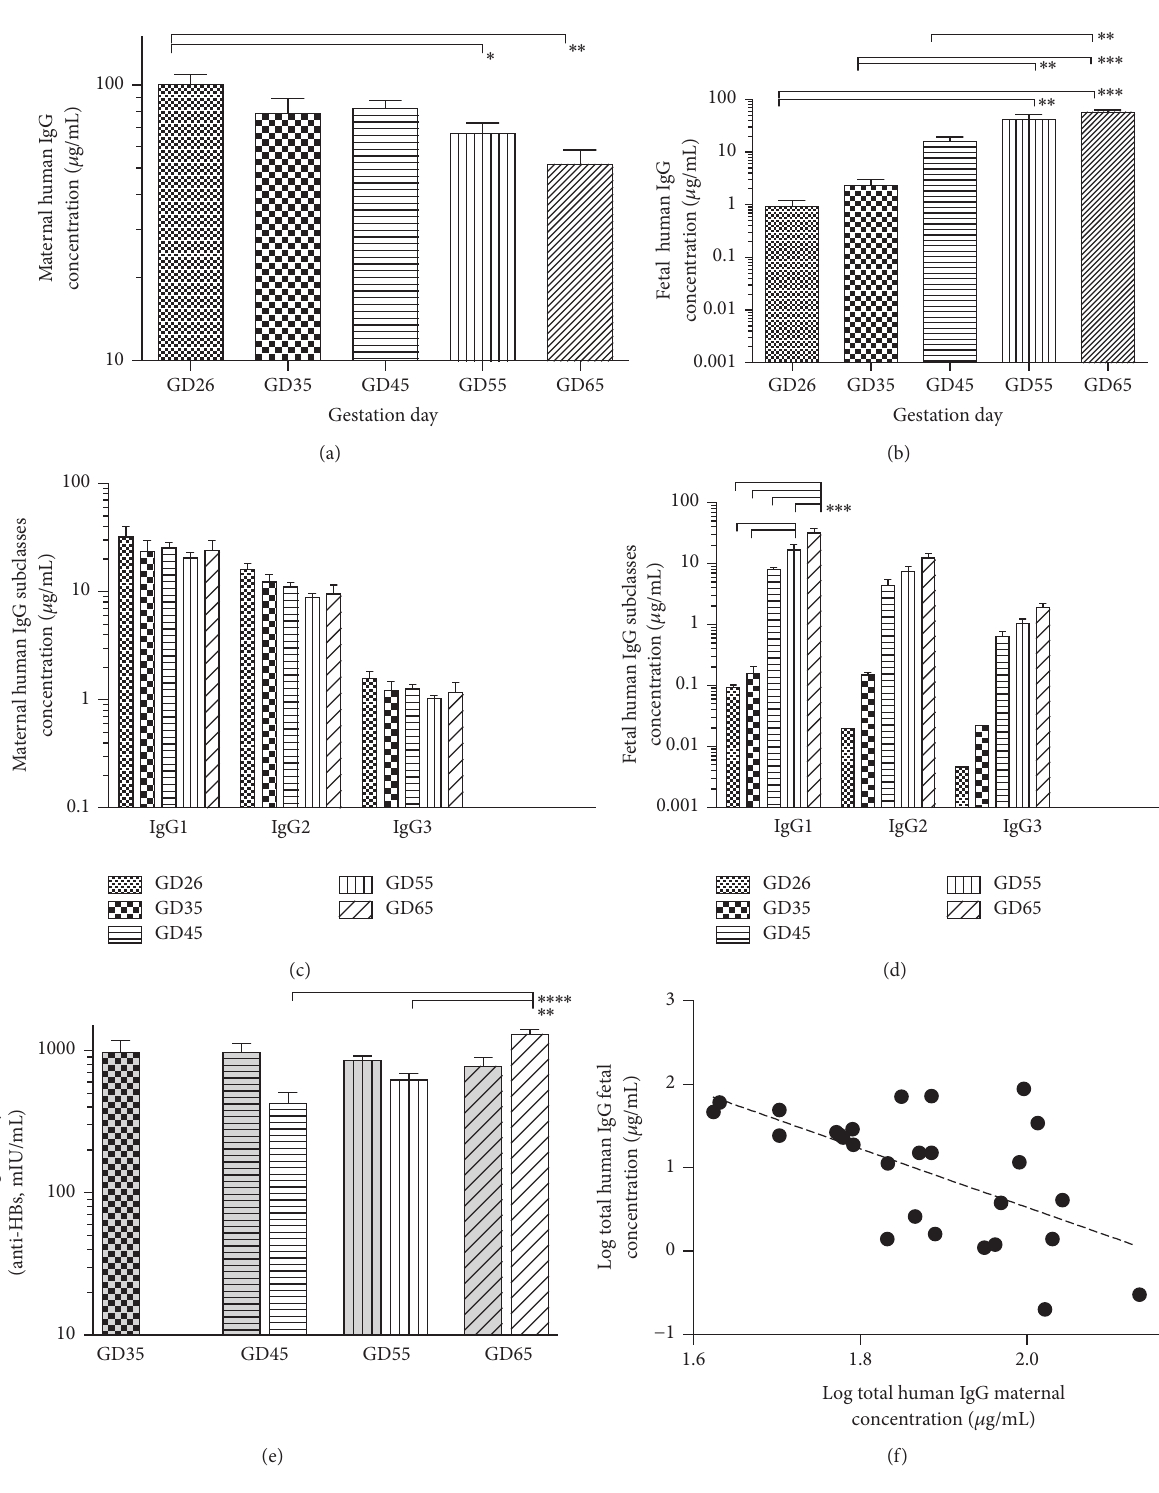
Figure3:MaternalandfetalconcentrationsofhumanIgGfollowinghepatitisBimmuneglobulin(HBIG)administrationatdifferentgestation ages. HBIG was administered intravenously at a dose 100 IU/kg ( ∼ 7mg/kg) at different gestation ages in timed-pregnant guinea pigs and total human IgG concentrations ((a), (b), (e), and (f)), human IgG subclasses ((c), (d)), and neutralizing activity (anti-HBs, (e)) five days after administration were measured. Shown gestation days (GD, 𝑥 -axis, or legend) roughly correspond to the end of first trimester (GD26), middle and end of second trimester (GD35 and GD45), and middle and end of third trimester (GD55 and 65). Maternal total human IgG concentrations decreased (a) and the corresponding fetal concentrations increased (b) with gestation. Similar trends were seen for human IgG subclasses in the maternal (c) and fetal (d) samples as well as the anti-HBs neutralizing activity in the mother ((e), shaded bars) and fetus ((e), clear bars). The maternal and fetal total IgG concentrations were negatively correlated (f) and, after log transformation, the relationship was linear (dotted line, Pearson 𝑟 = −0.60 , 𝑝 = 0.0008 ). Data shown as mean ± SEM; ∗ 𝑝 < 0.05 , ∗∗ 𝑝 < 0.01 , ∗∗∗ 𝑝 < 0.001 , and ∗∗∗∗ 𝑝 < 0.0001